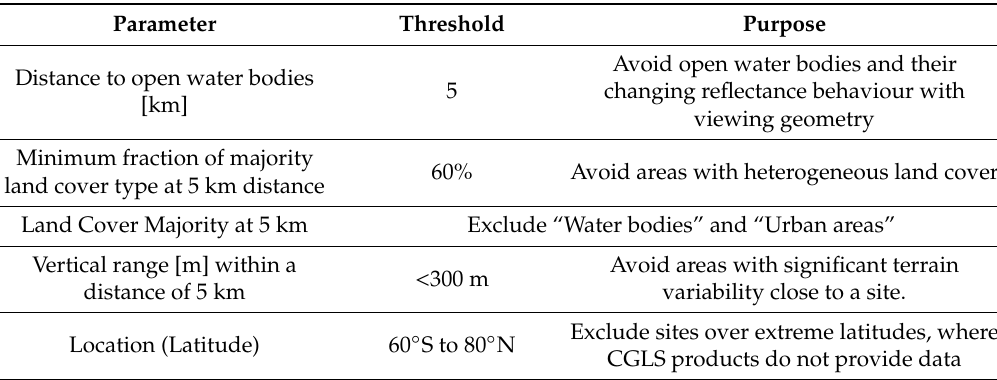
Figure A1. Global distribution of the 725 LANDVAL sites. Table A1. Criteria for selection of the LANDVAL sites.